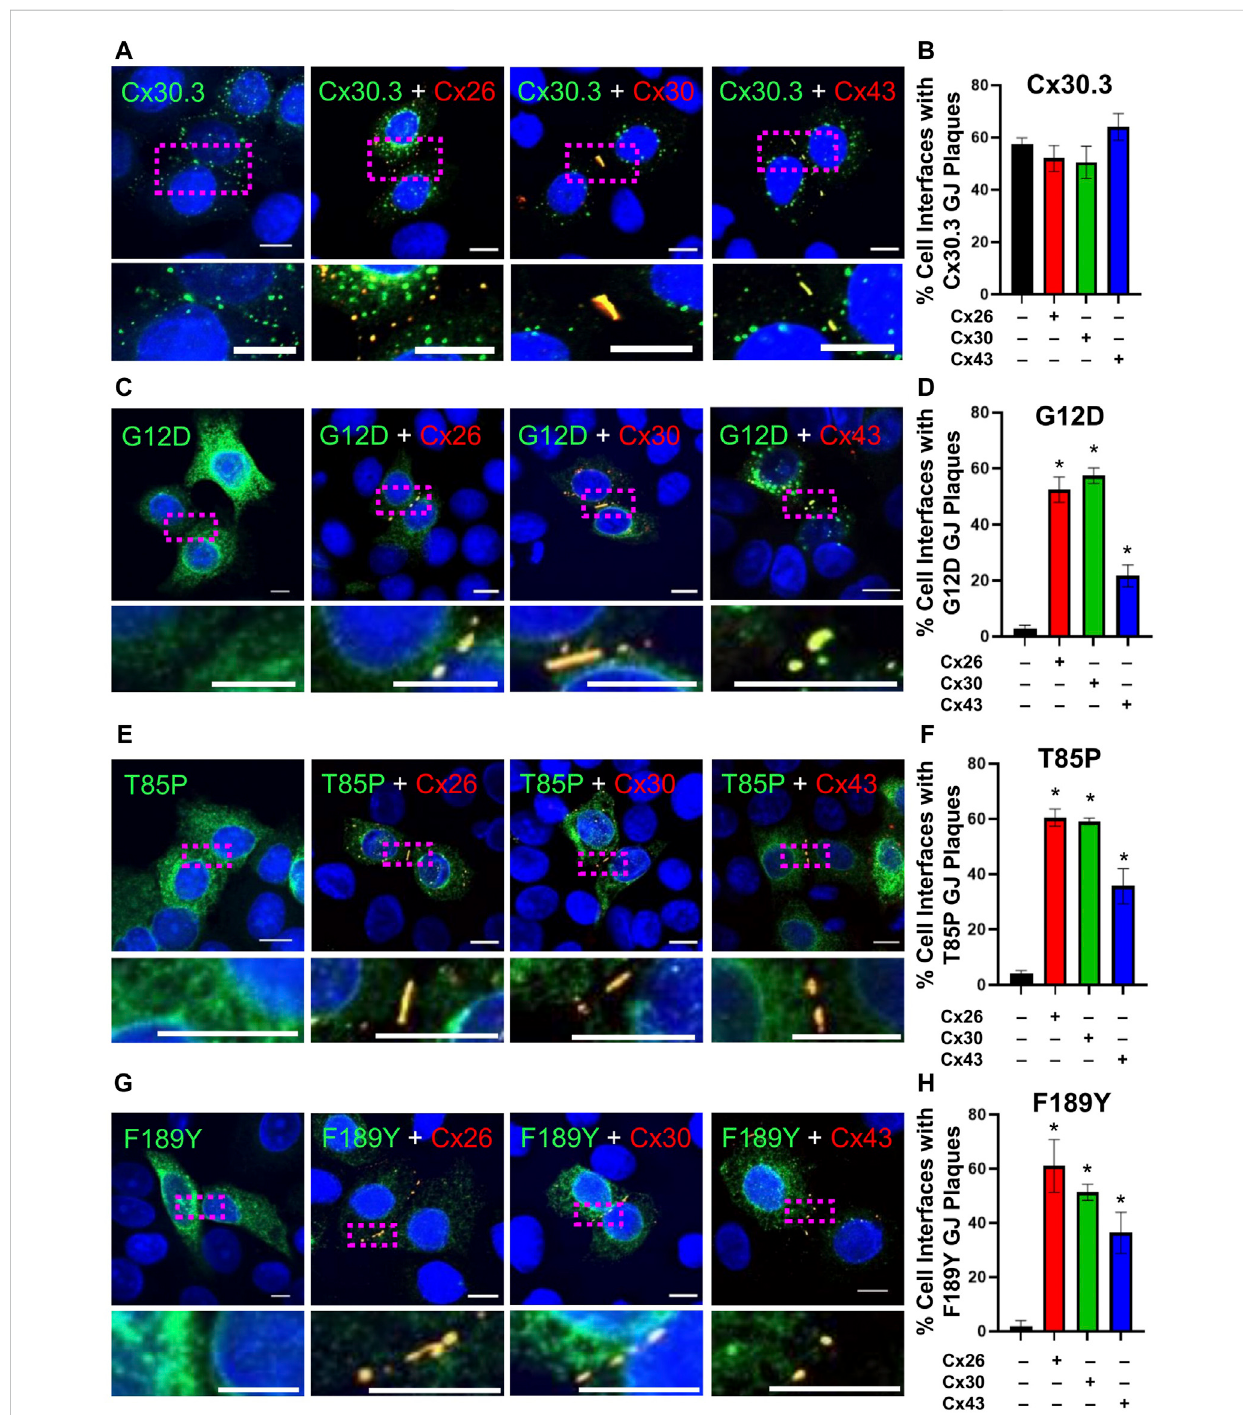
FIGURE 9 Co-expression of keratinocyte connexins partially restores Cx30.3 mutant traf fi cking and assembly into gap junctions. (A, B) Cx30.3 (green) forms gapjunctionsaloneandwhenco-expressedwithCx26,Cx30,orCx43(red). (C,D) G12D(green), (E,F) T85P(green),and (G,H) F189Y(green)mutantsare readily found in gap junctions when co-expressed with Cx26, Cx30, or Cx43 (red). Dashed boxes indicate the areas magni fi ed in the inserts. Nuclei counterstained with Hoechst 33342 (blue). N = 3 for all experiments. Scale bars = 10 µm * p <